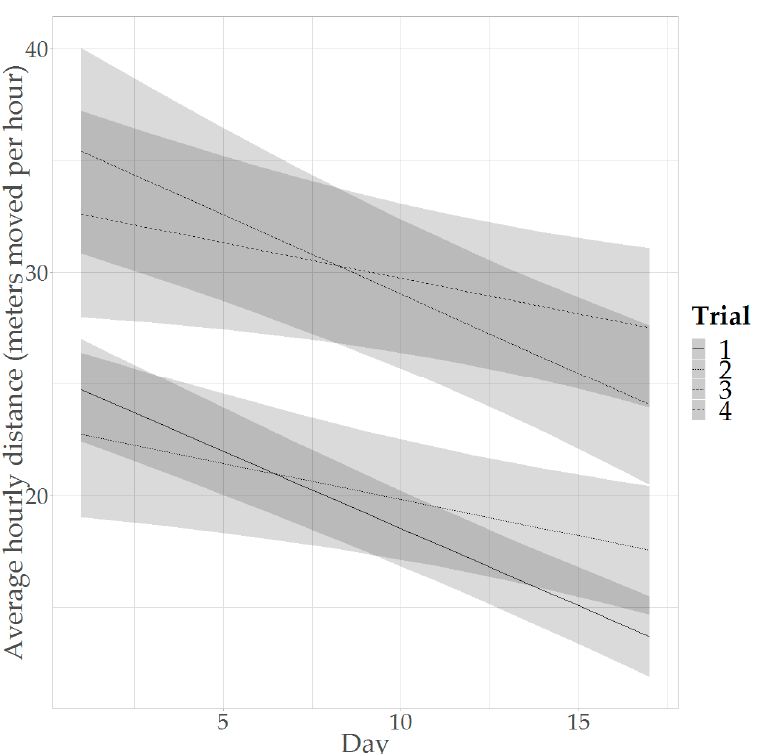
Figure 2. Predicted activity over the tracking period (day 1 to 17 of tracking, corresponding to day 16 to 32 of life) in the activity model, distinguishing between the different trials. Shaded areas represent 95% CIs.